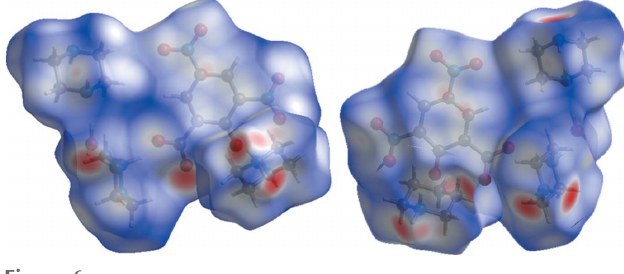
Figure 6 Two different views of the Hirshfeld surface of (I).